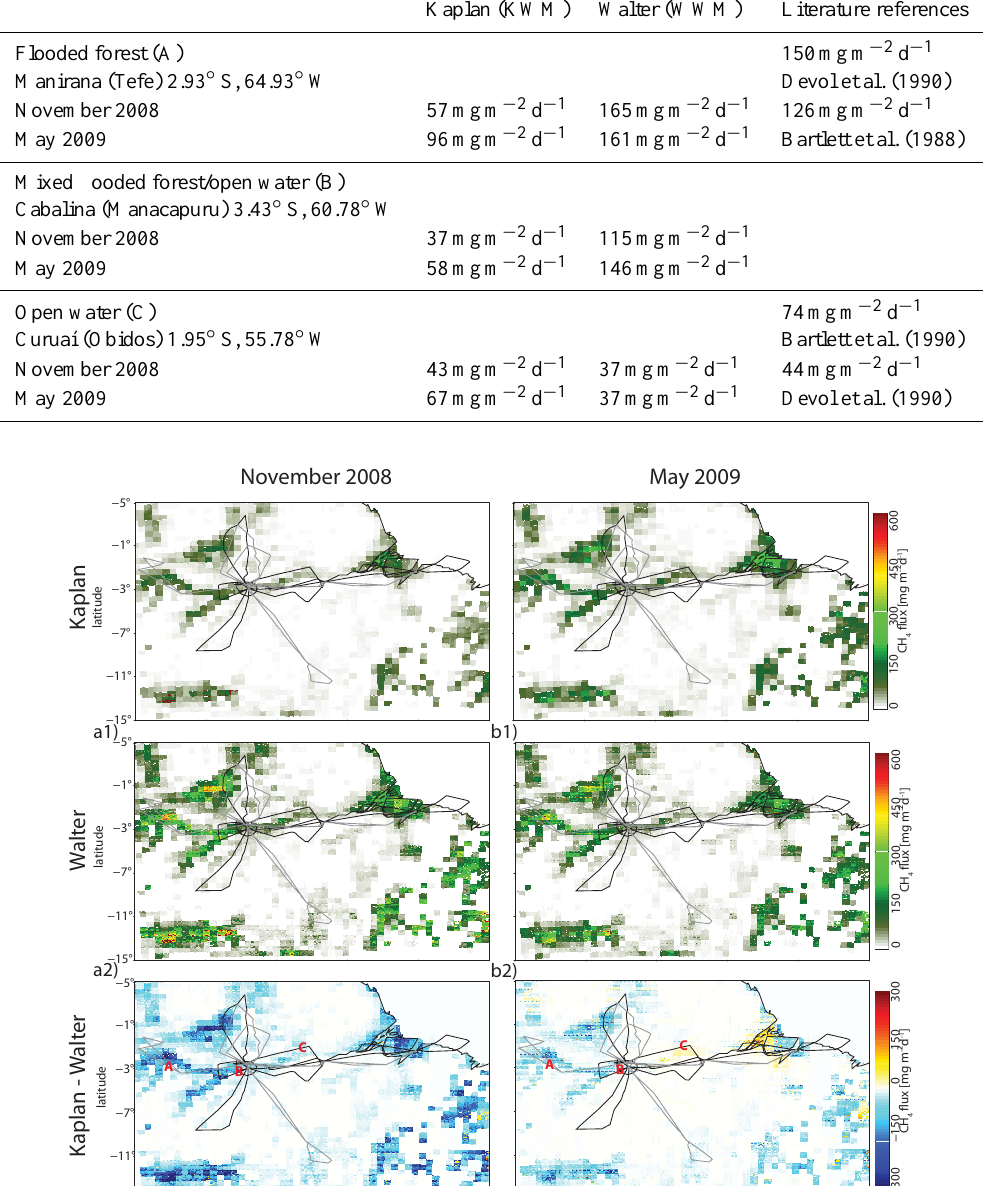
Table 2. Comparison of the CH 4 flux from the Kaplan wetland emission model (KWM) and the Walter wetland model (WWM) for grid cells specific for different wetland types (flooded forest, mixed flooded forest/open water, open water; cf. Hess et al. (2003) Fig. 8). The locations for the three different grid cells are illustrated as (A), (B), and (C) in Fig. 5a3–b3. In addition, literature values for the specific wetland types are denoted.